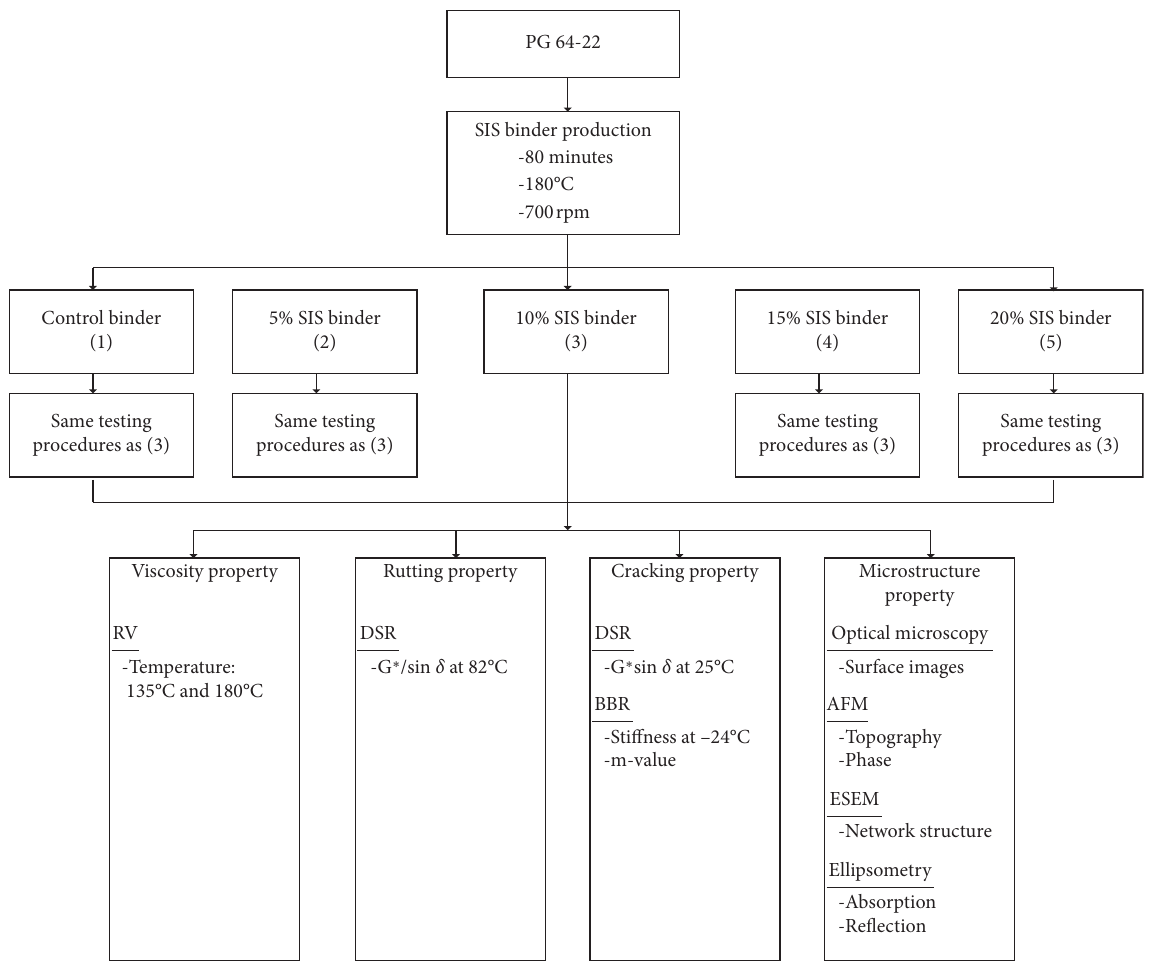
Figure 1: Flow chart of experimental design.